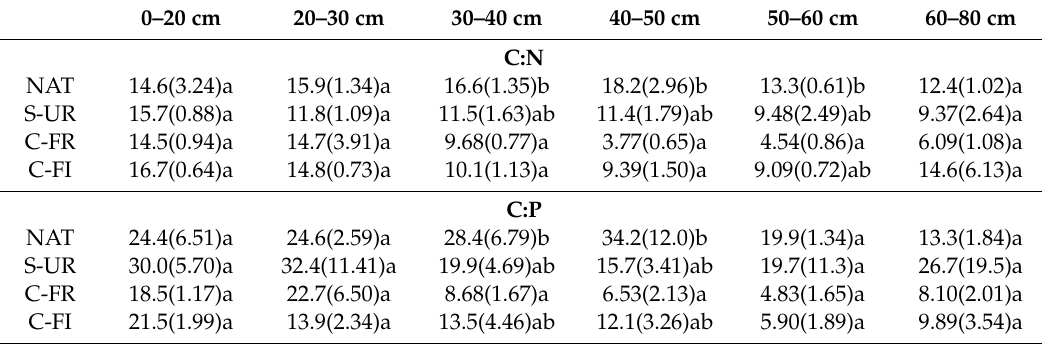
Table 4. Means of the observed soil C:N (top) and C:P (bottom) ratios through the sampled depths for each LMP. Bracketed numbers are standard error (n = 5). Di ff erent letters in the same column indicate significant di ff erence ( p < 0.05) between LMPs determined using one-way analysis of variance and Tukey’s honestly significant di ff erence post hoc